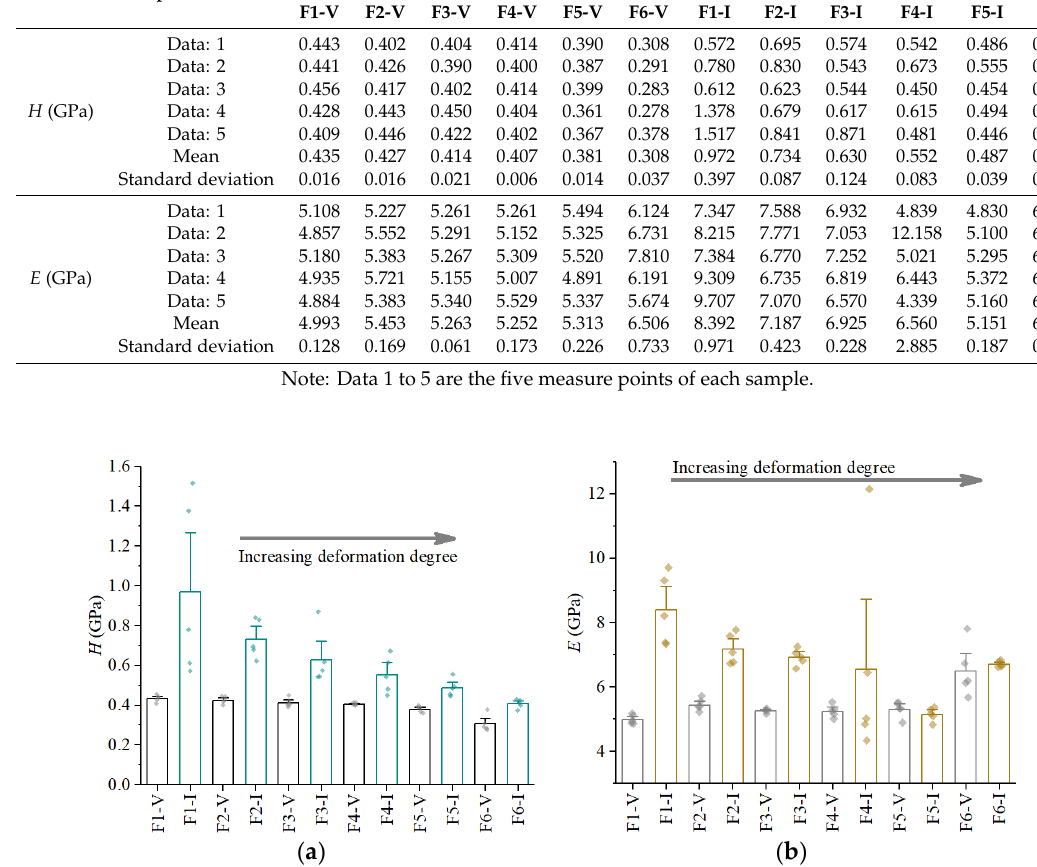
Table 3. Calculation results of E and H.